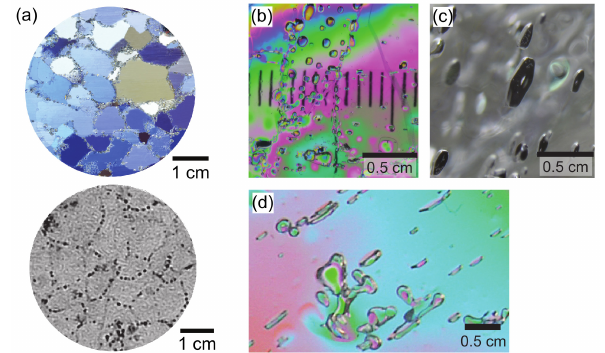
Figure 6. Box plots comparing the distribution of ice crystal charac- teristics (area, long axis, circularity ratio) of horizontal thin sections (H) and vertical thin sections (V) obtained from massive ice sam- ples. C-93 represents data obtained from a sample of modern glacier ice sampled from glacier